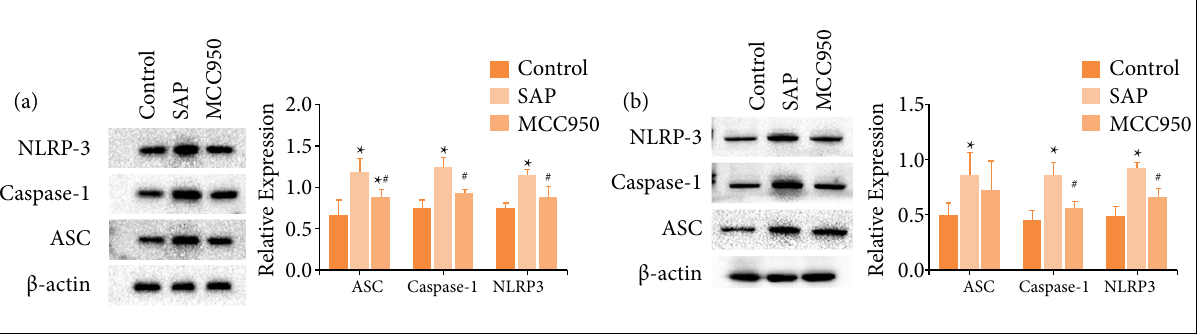
Figure 2 - The effect of MCC950 on the expression of NLRP3 inflammasome; (a) The expression level of NLRP3 inflammasome in pancreas; (b) The expression level of NLRP3 inflammasome (ASC, caspase-1 and NLRP3) in small intestine. The results are expressed as mean ± standard deviation. N = 6; * p < 0.05 vs. control; # p < 0.05 vs.